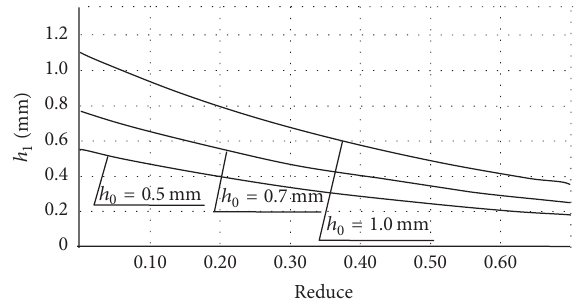
Figure 12: The results of automated design of the final thickness of the coating, depending on the reduce. R1 =50mm; a 1 = 0.124; a 2 = 0.052; a 3 = − 3.70; 𝜎 𝜏0 = 60.1 N/mm 2 ; 𝜆 = 0.26 . a frequency of 100 kHz and a gain opportunity in the range of 1 to 1000. The oscillograms were recorded by a converter of voltage measuring E14-140 (Figure 13(b)). The converter is designed to perform tasks with feedback signals. Monitoring, software Usb Oscilloscope (version 3.1.2.8) at a scale of 1 :